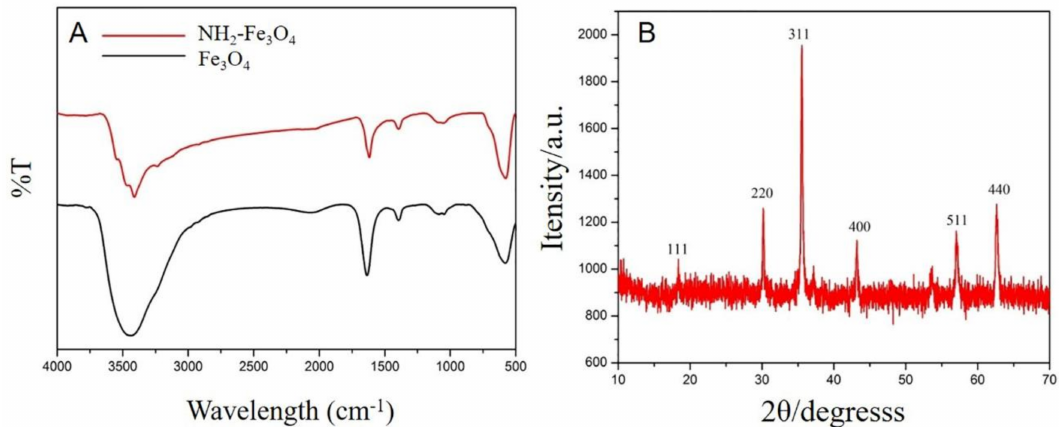
Figure 2. ( A ) Fourier-Transform Infrared (FTIR) spectra of Fe 3 O 4 and NH 2 –Fe 3 O 4 ; ( B ) the X-ray Diffraction (XRD) pattern of Fe 3 O 4 NPs.